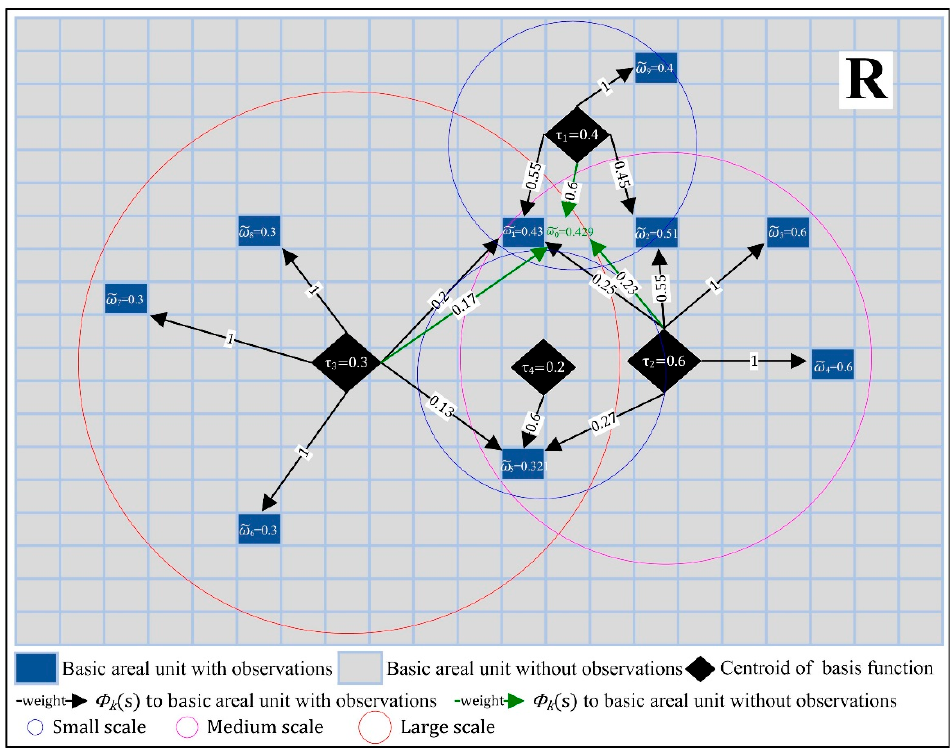
Figure 2. An illustration of heterogeneous random process captured by multi-scale spatial basis function.